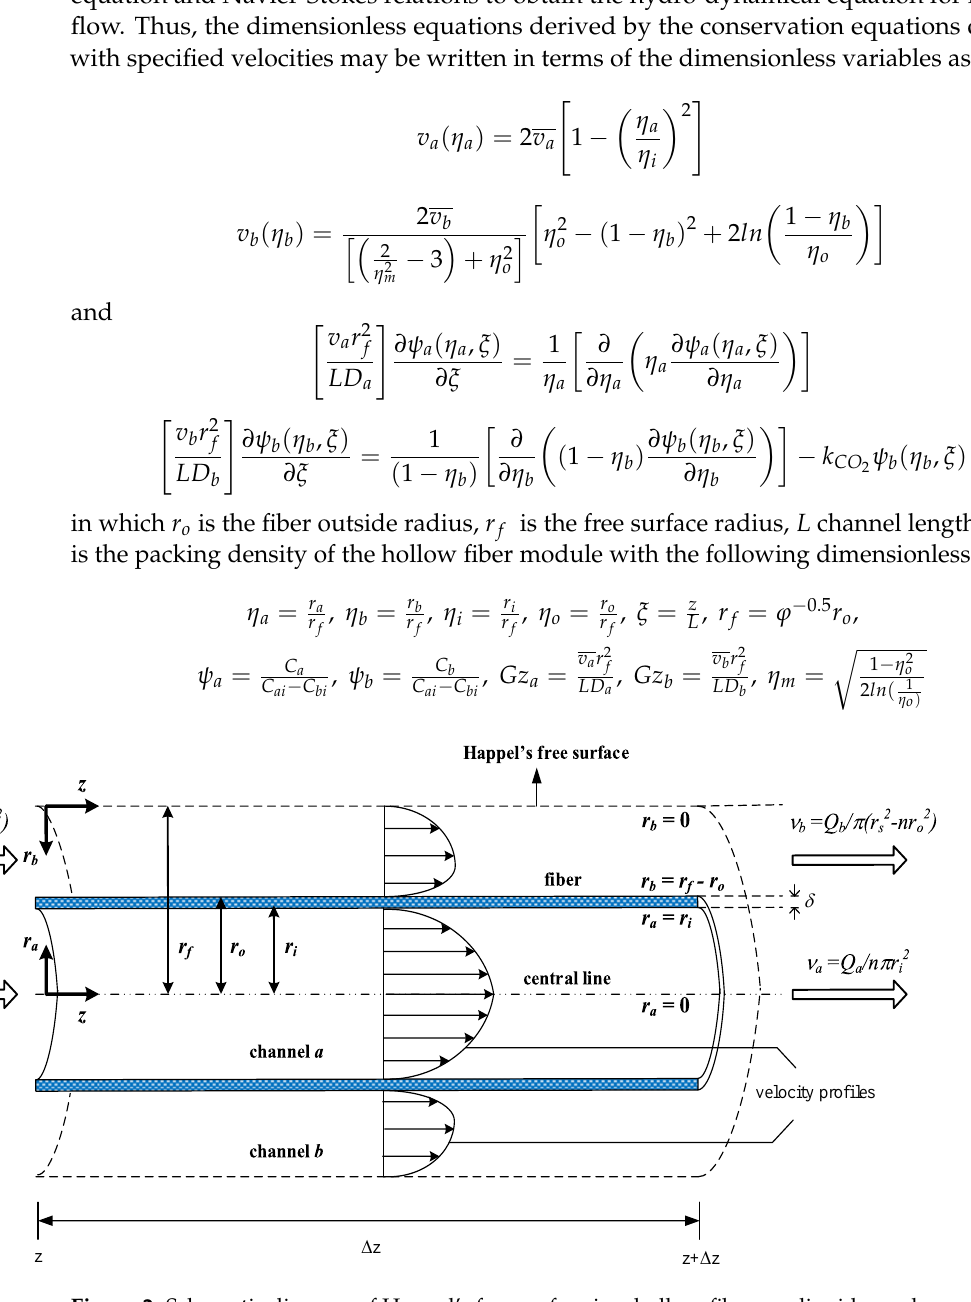
Figure 2. Schematic diagram of Happel’s free surface in a hollow-fiber gas-liquid membrane module.